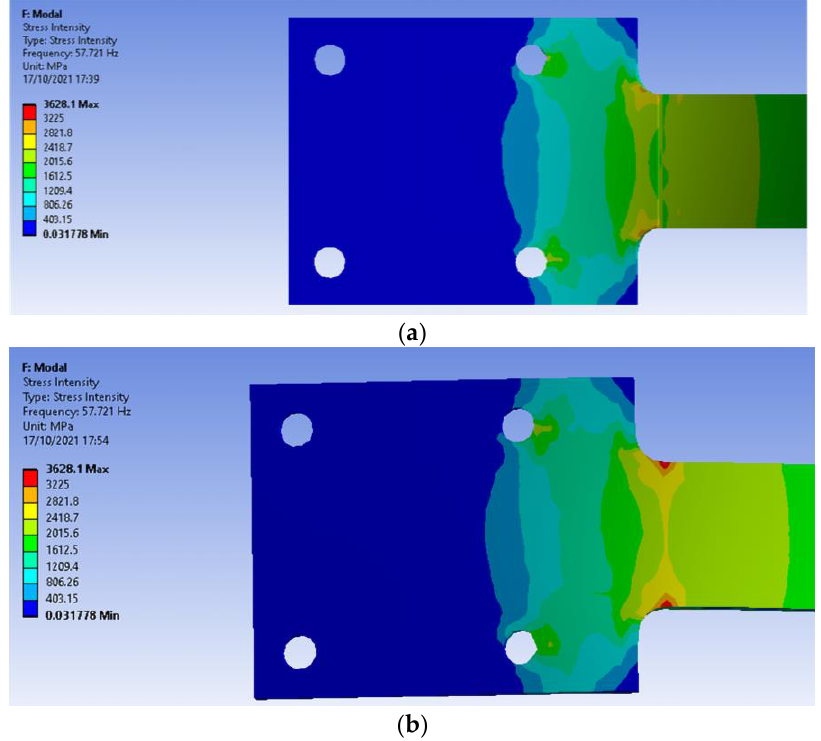
Figure 10. Stress intensity of 0.25 mm crack depth at 100 – 180 °C. ( a ) Top view , ( b ) Bottom view .